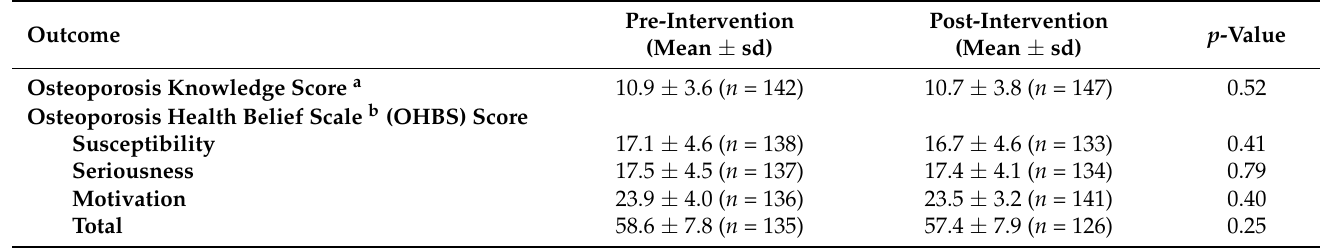
Table 2. Osteoporosis Knowledge Score and Osteoporosis Health Belief Scale